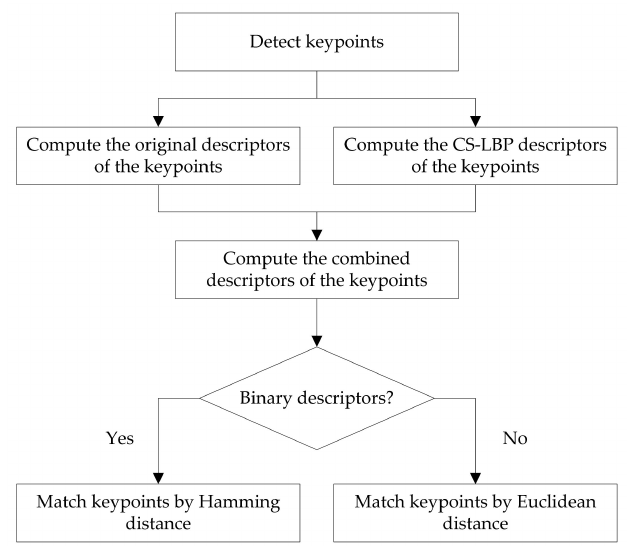
Figure 3. Flow chart for calculating the combined descriptors and matching the keypoints.